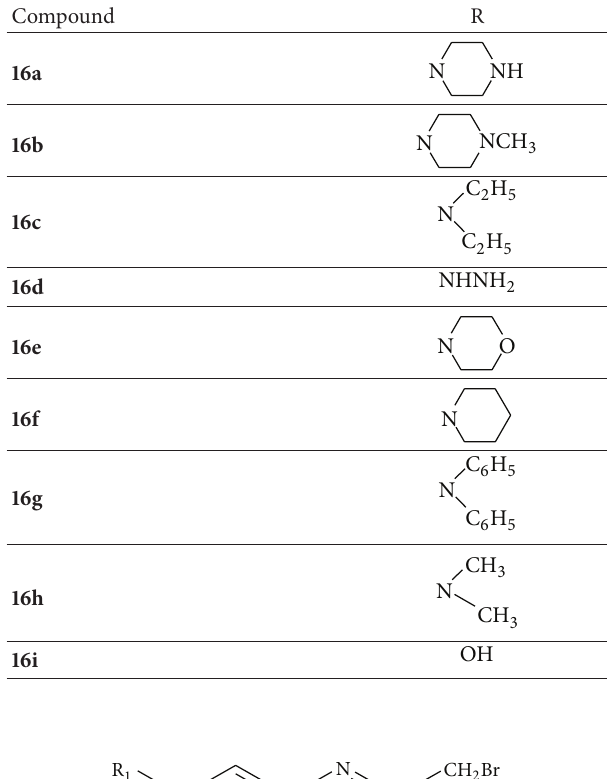
Table 5: List of compounds prepared.